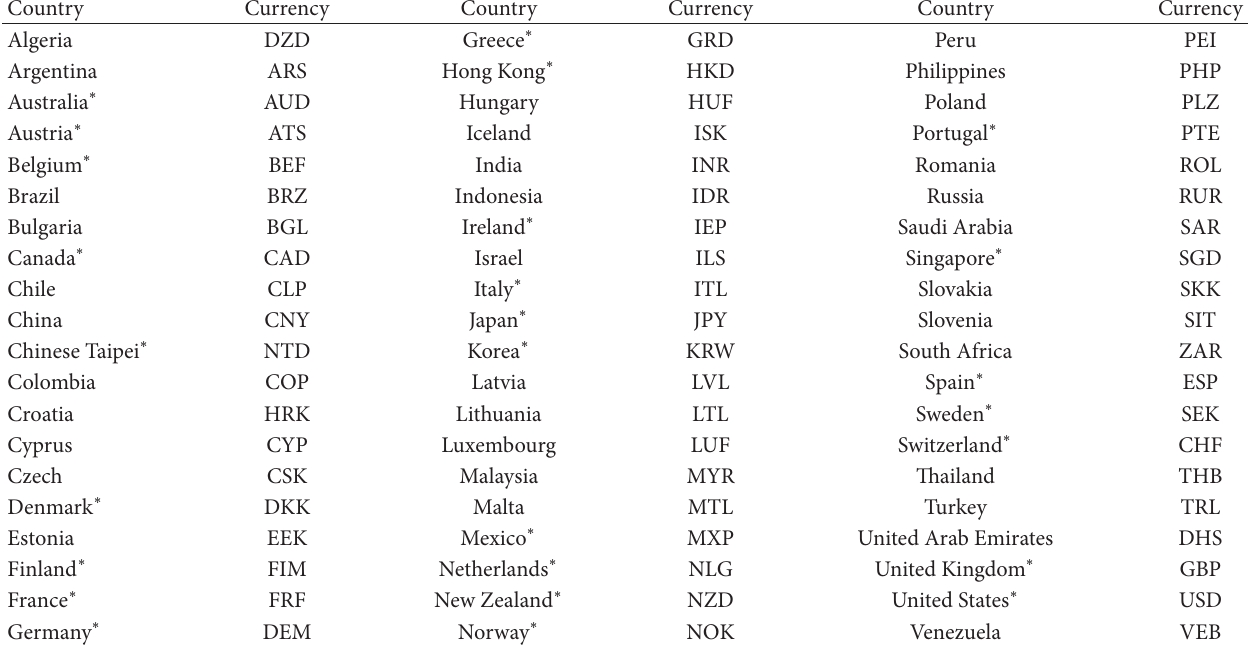
Table 1: Sixty-one currencies and their